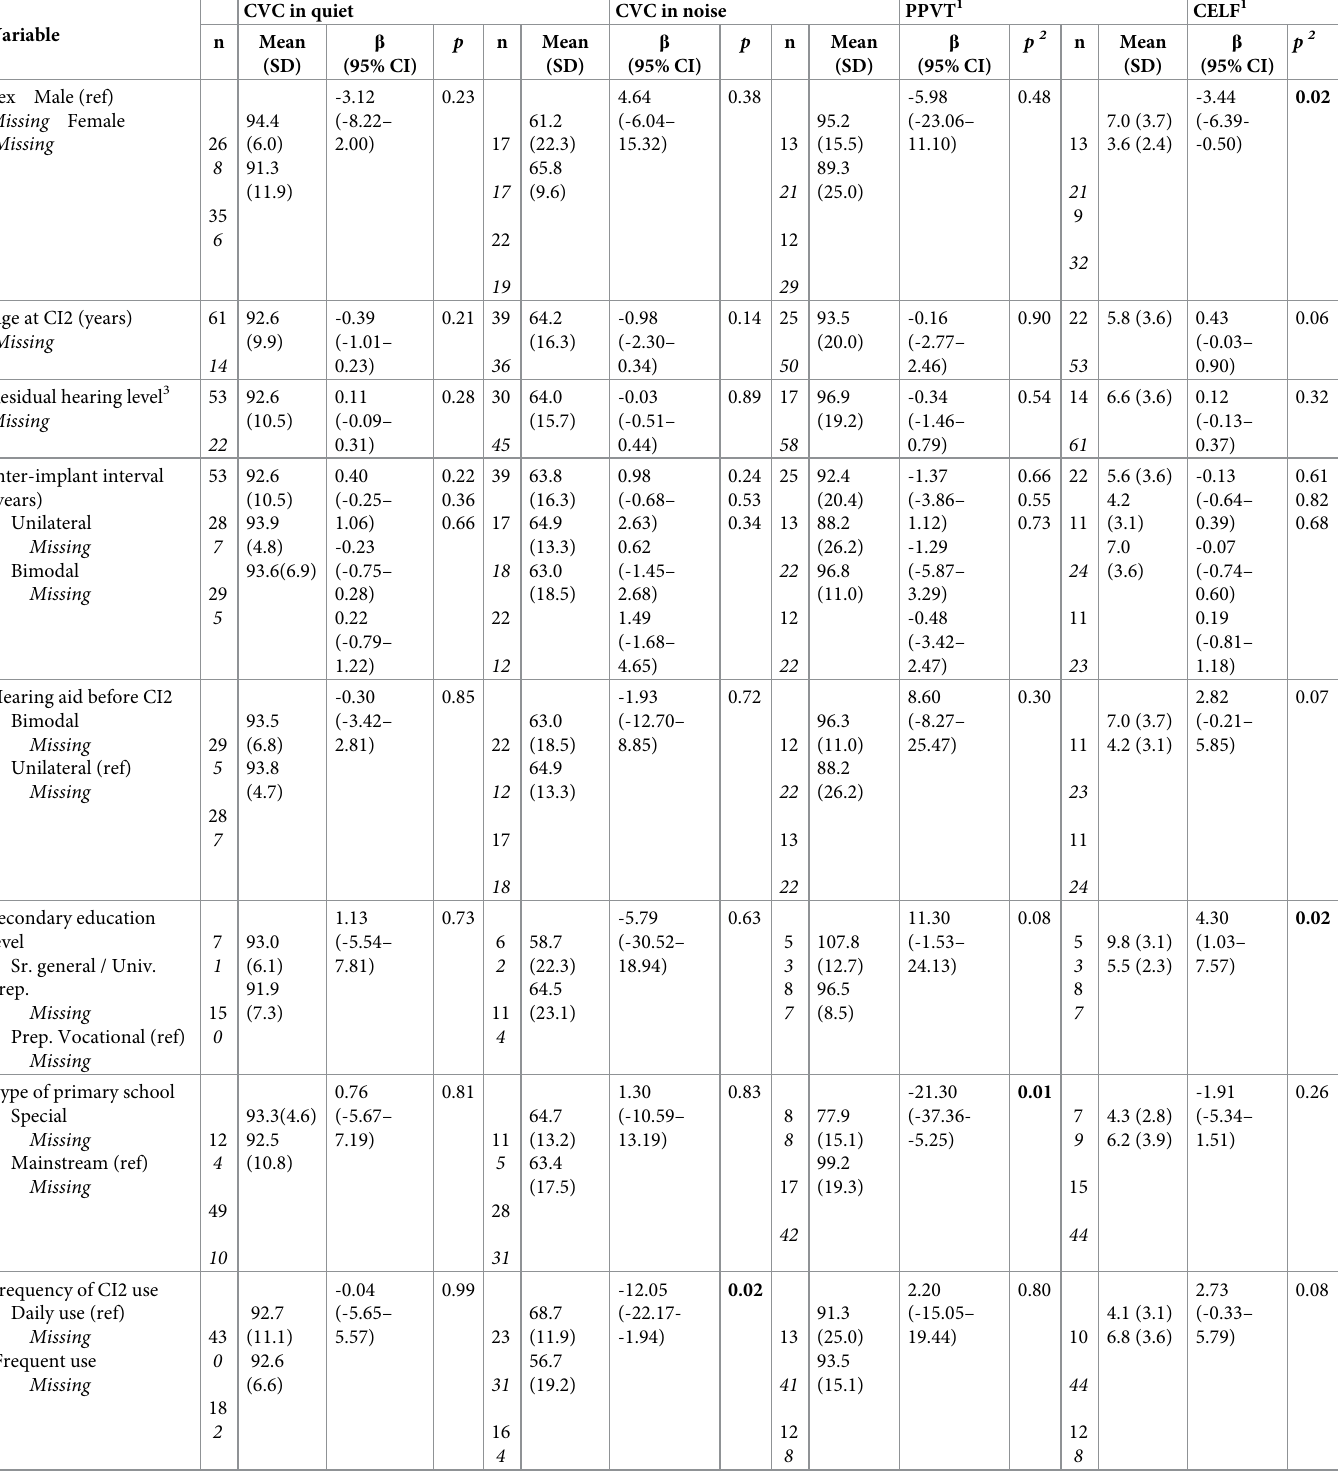
Table 4. Univariable linear regression analysis of outcomes of CI2 users 12 months after the second cochlear implant (CI2).